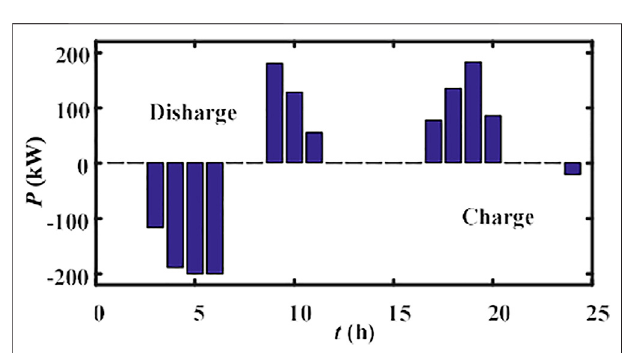
FIGURE 18 | Daily dispatch plan of the